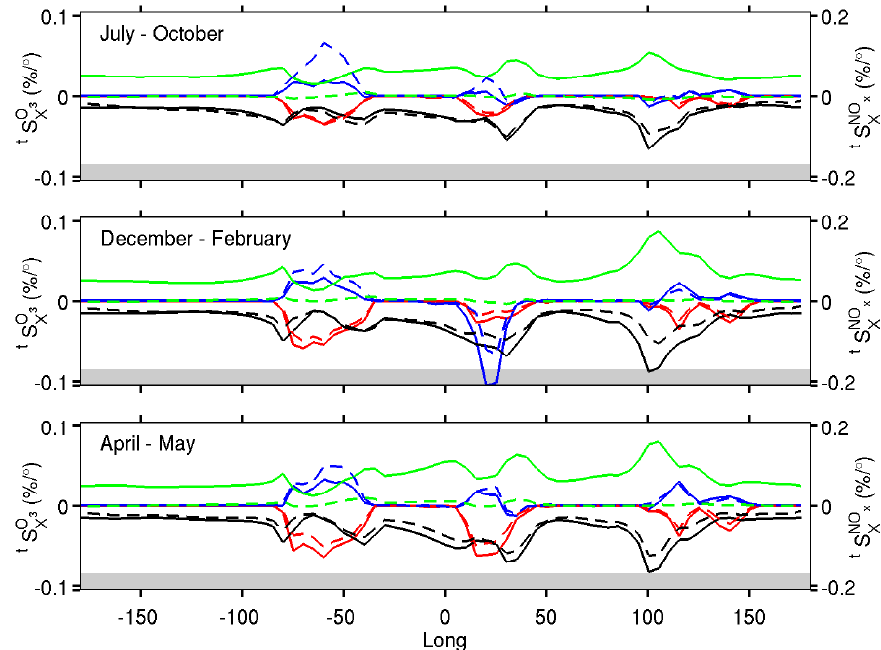
Fig. 5. Adjoint sensitivity of tropical ozone (solid lines) and NO x (dashed lines) to changes in the isoprene nitrate yield (red), the isoprene nitrate recycling (blue, × 5 ), the loss rate of methane (green, CH 4 + OH), the rate of OH + NO 2 (black, × 0 . 5). For example, the mean sensitivity of tropospheric tropical ozone to methane oxidation from July to October is ∼ 0 . 028% per degree longitude (from − 15 ◦ N to 7 ◦ N). Hence, a uniform increase of 1% of the oxidation rate of methane by OH is predicted to cause an increase in tropospheric tropical ozone of ∼ 0 . 1%. In contrast, an increase of the isoprene nitrate yield (Y) by 1% would result in a decrease in ozone of ∼ 0.02%. Increases in the absolute sensitivity of ozone to NO x losses from one season to another (e.g., over Africa from December–February to April–May) reflect changes in OPE. The grey shaded region denotes the region over which the cost functions are evaluated.